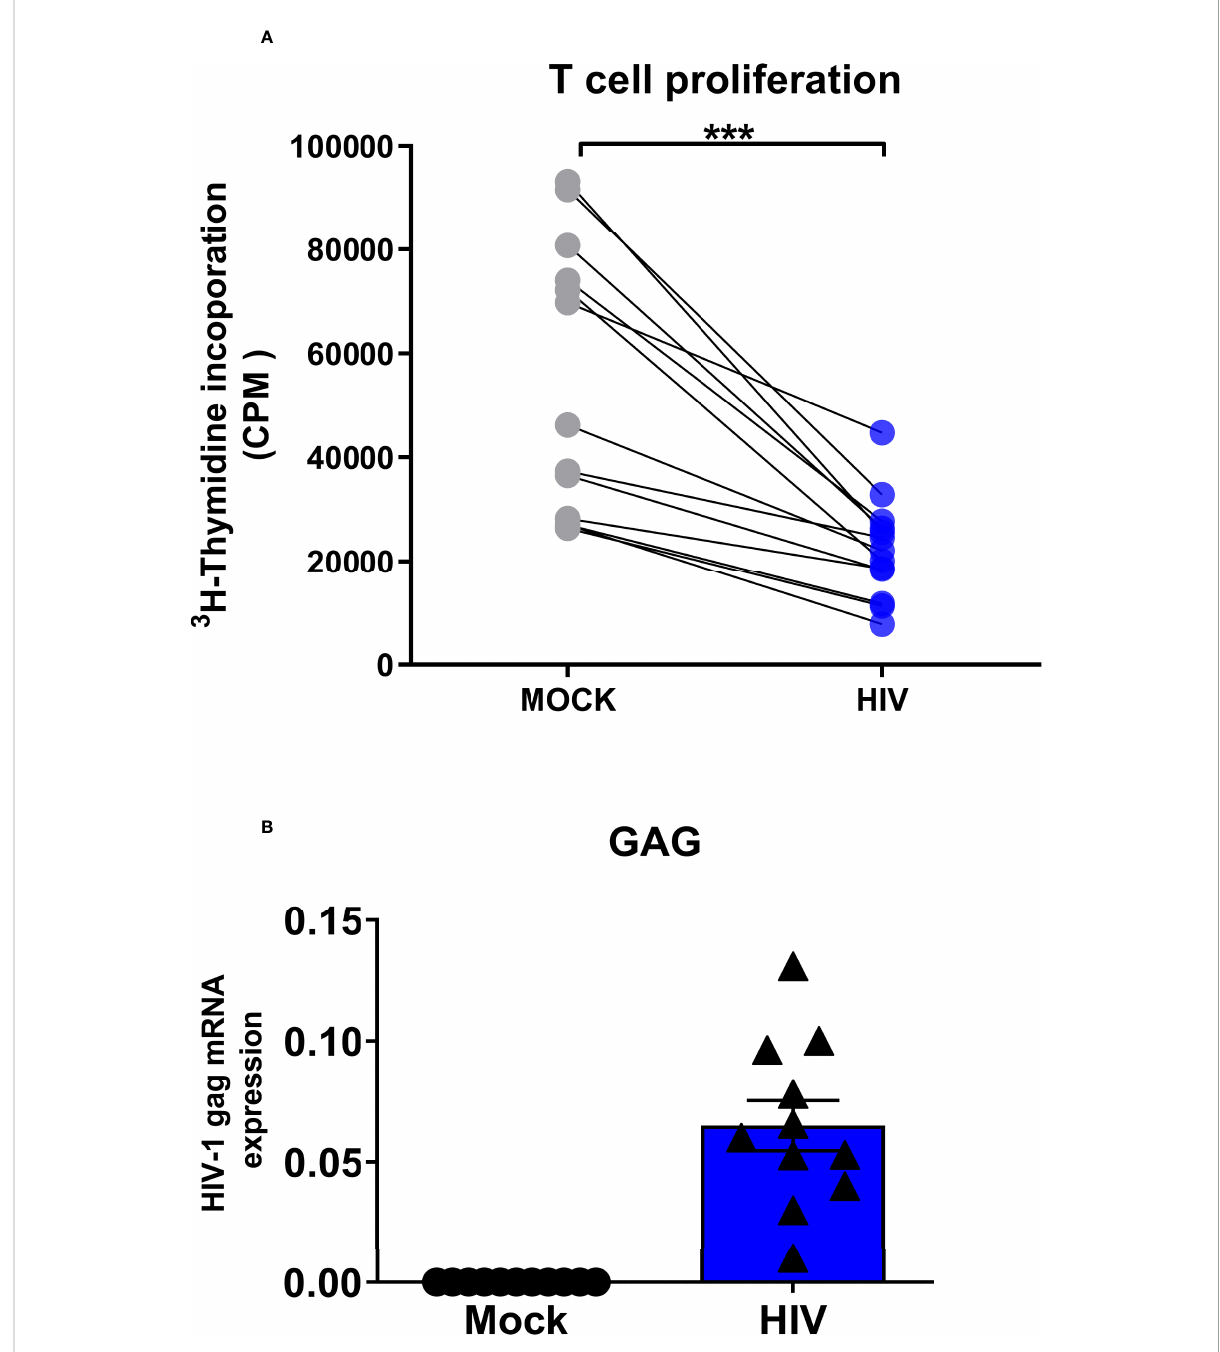
FIGURE 2 Presence of infectious HIV impairs the ability of DCs to prime naïve T cell responses. Mature DCs were pulsed with infectious HIV-1 BaL (CCR5- tropic) overnight, washed twice, and cocultured with naïve bulk T cells at a ratio of 1:10 (10 4 DCs and 10 5 T cells). The primed cultures were restimulated with 10000 DCs per well after 7 days of coculture, and T cell proliferation was determined by [ 3 H] thymidine incorporation into the DNA of proliferating T cells day 8 by liquid scintillation counting using a micro- b counter. Values expressed as counts per minute (CPM) (A) . The levels HIV gag transcripts at day 8 in the HIV exposed and unexposed DC-T cell cocultures were measured by PCR (B) . N=11-13. *** P <0.001, paired